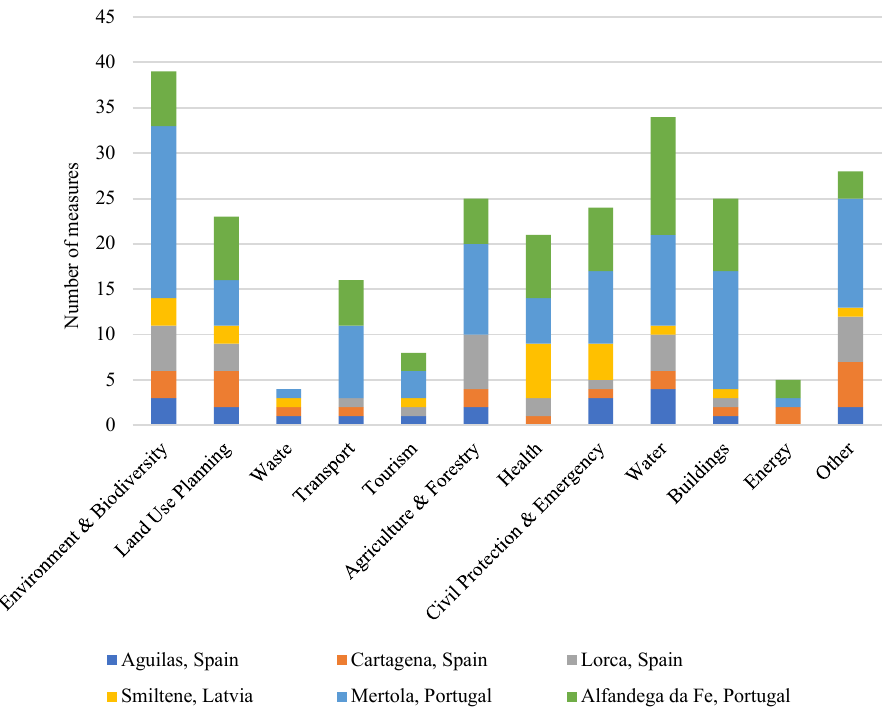
Fig. 2. SECAP measures divided by